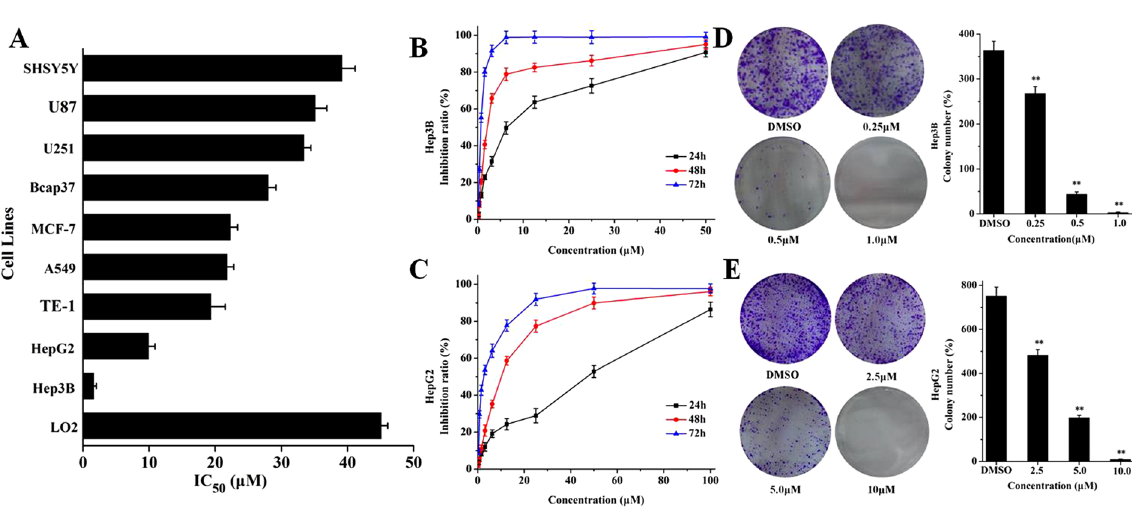
Figure 2. The effects of daphnegiravone D on cancer cells viability. ( A ) Selective inhibition of daphnegiravone D on nine kinds of cancer cell lines and one human normal hapatic cells. The inhibitory intensities were expressed as IC 50 . ( B , C ) Inhibition ratio of Hep3B and HepG2 cells treated with various concentrations of daphnegiravone D (0.2–50.0 μ M for Hep3B and 0.4–100.0 μ M for HepG2 cells) for 24, 48 and 72 h, respectively. The inhibition ratio was detected by MTT assay. ( D , E ) Colony formation assay demonstrated that daphnegiravone D decreased the colony formation ability in Hep3B and HepG2 cells. The number of colonies in each of the treatment groups were counted under the microscope. The statistic results are expressed as mean ± SD, n = 3, ** p < 0.01 compared with control group.